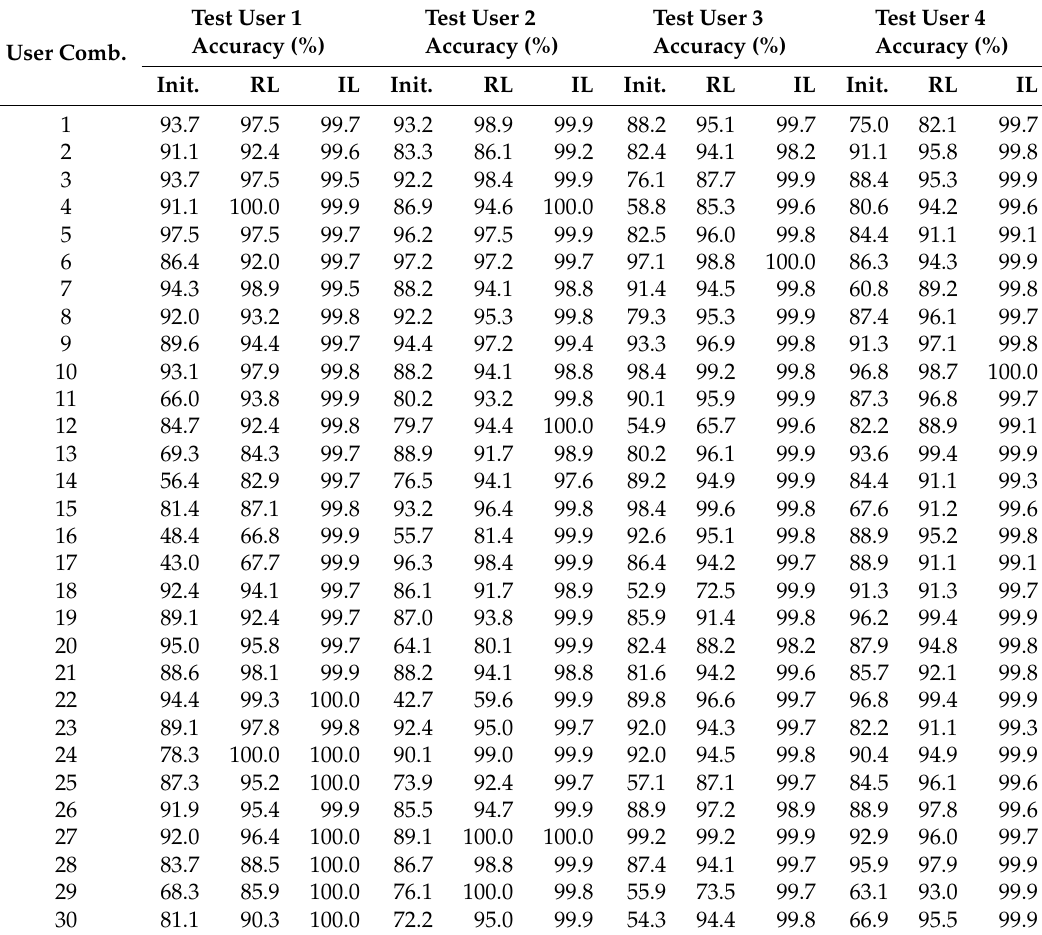
Table 9. Comparison of accuracy improvement with online